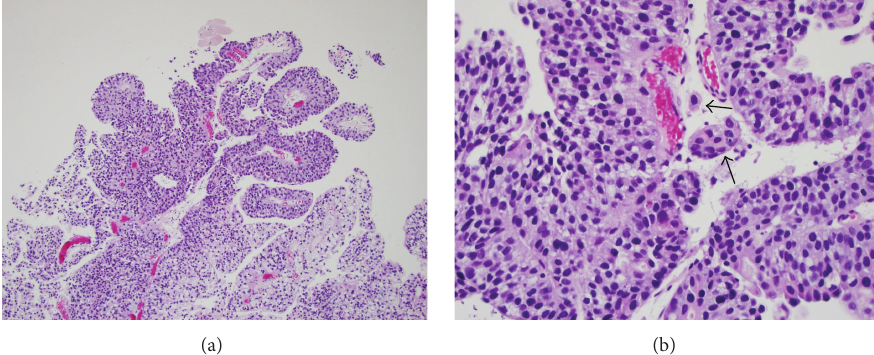
Figure 3: (a) Low power view of high-grade papillary urothelial carcinoma. (b) High power view of invasive high-grade papillary urothelial carcinoma. There is invasion of the lamina propria by tumor cells